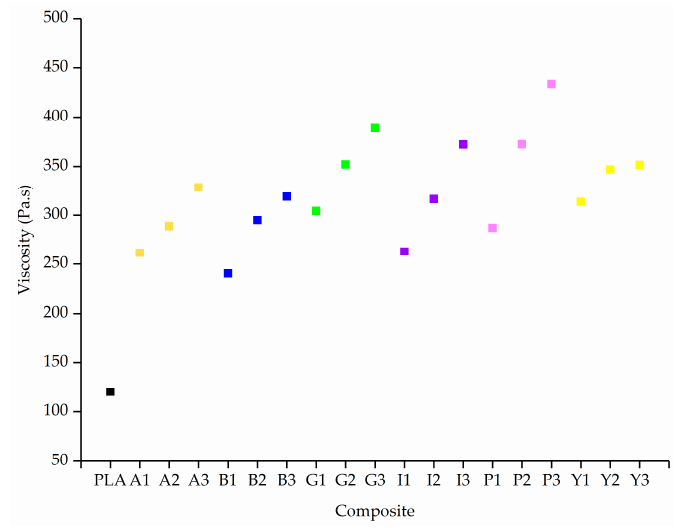
Figure 9. Viscosity of PLA and its composites containing 1%, 2% and 3% (w/w) of each additive at a shear rate of 5 rad/s. The colored squares indicate the different dyes/pigments for visual clarity.